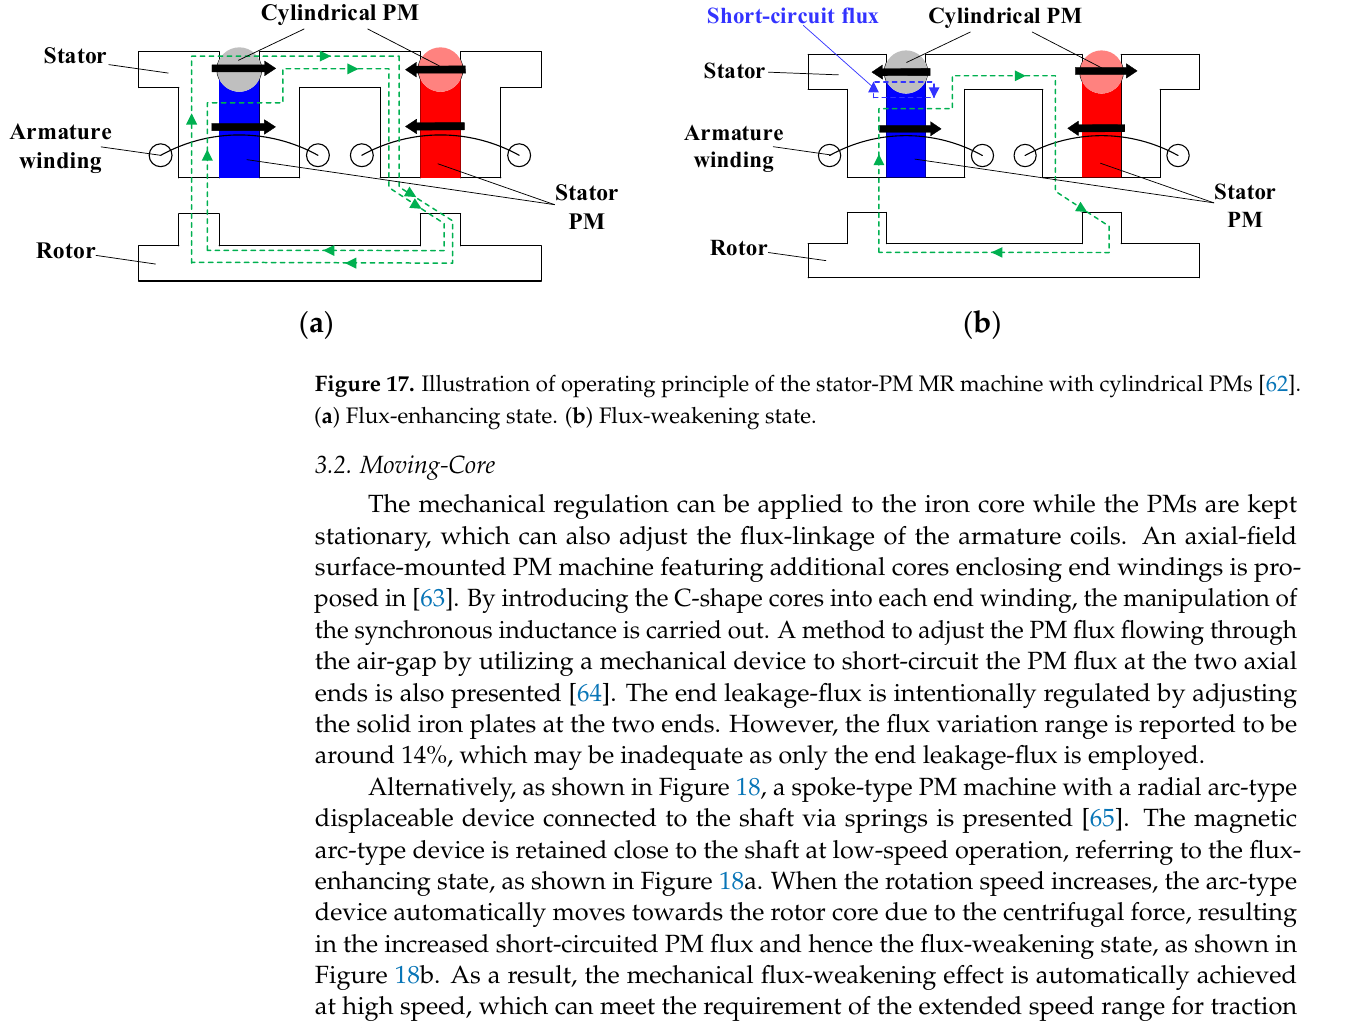
( a ) Flux ‐ enhancing state. ( b ) Flux ‐ weakening state.